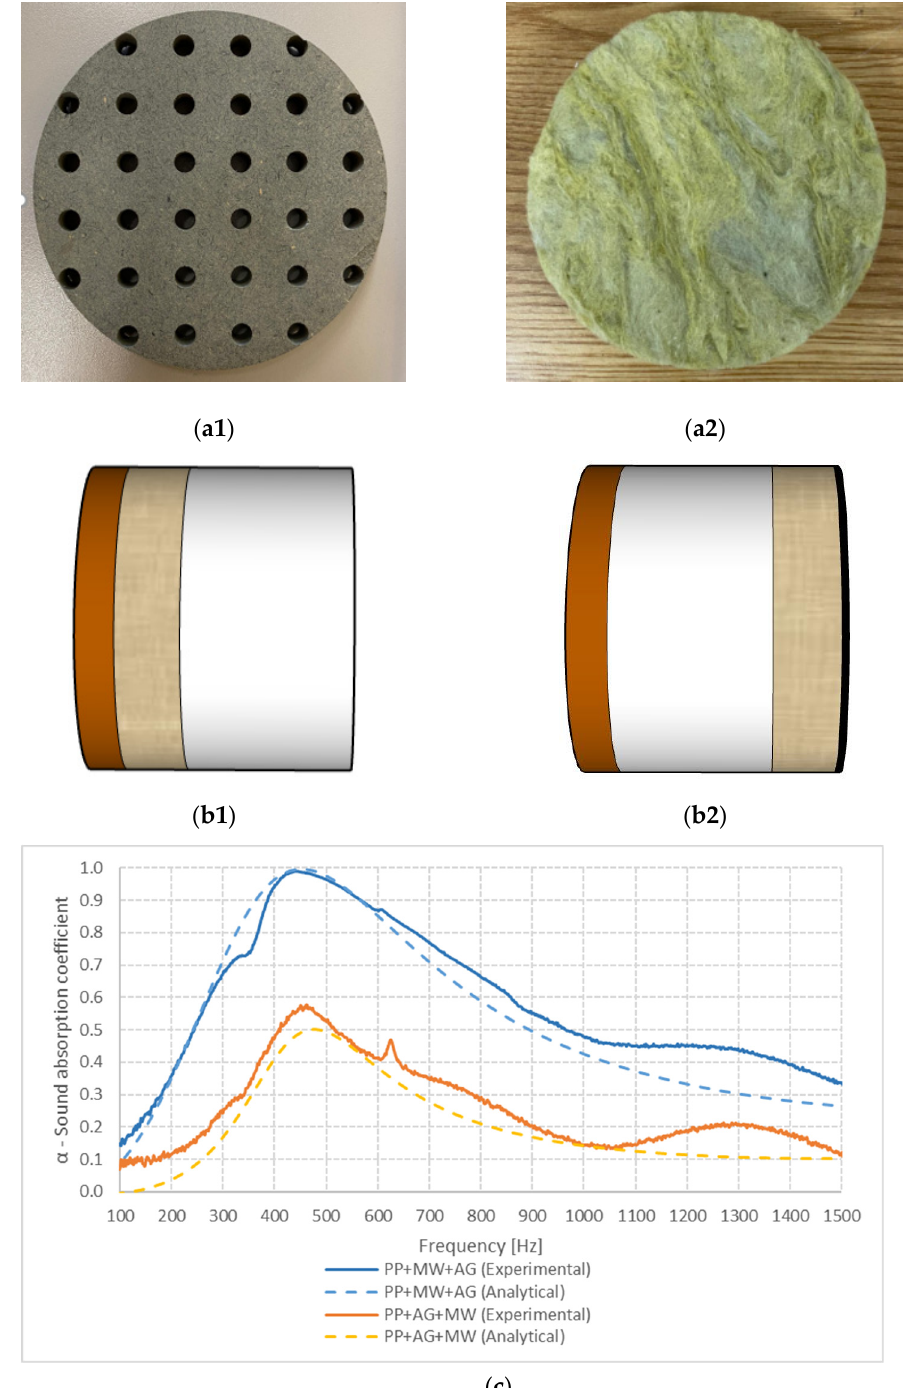
Figure 3. Comparison of the TMM and the experimental results, for two of the analyzed cases: ( a ) composition of samples: ( a1 ) perforated panel; ( a2 ) mineral wool; ( b ) configurations tested: ( b1 ) PP + MW + AG; ( b2 ) PP + AG + MW; ( c ) results calculated by the analytical approach and experimental data.